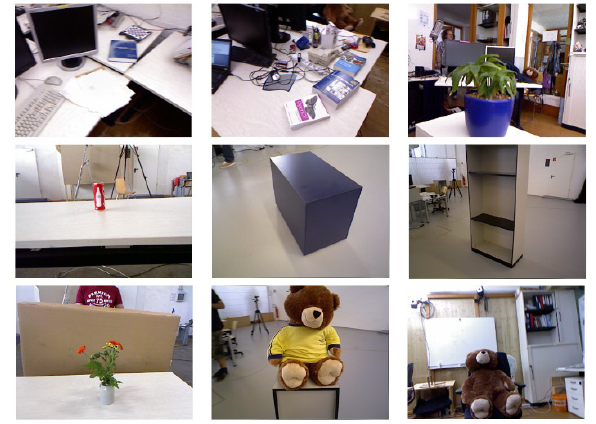
Figure 7. Example image frames of the test datasets.